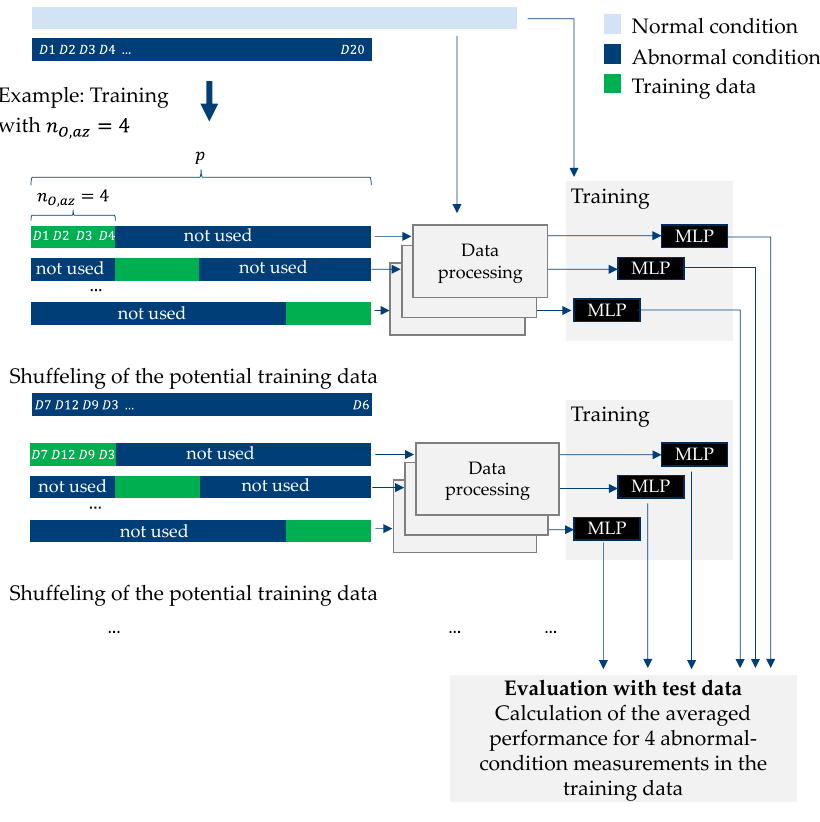
Figure 14. Illustration of the testing process for 4 abnormal-condition measurements in the training data.